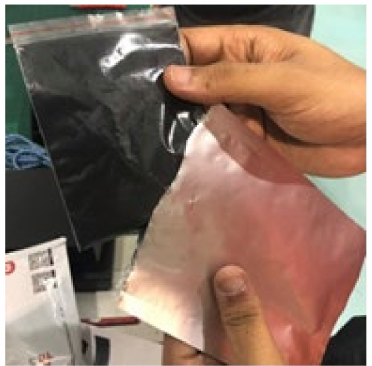
Figure 1. Helical multiwalled carbon nanotubes (HMWCNTs) used in the experimental